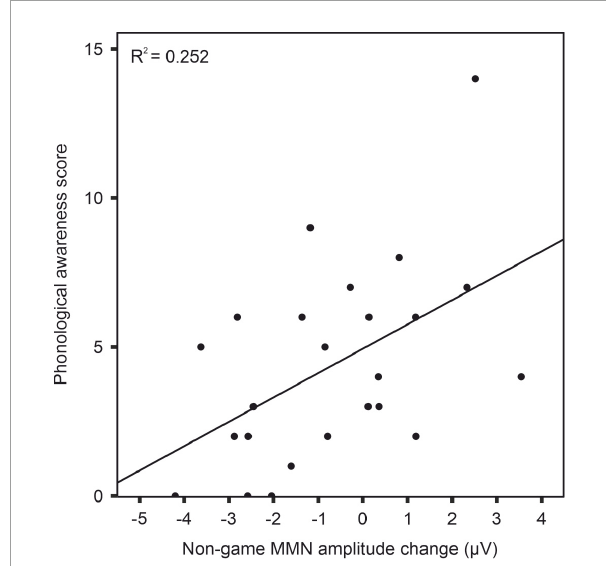
FIGURE7 Correlation between phonological awareness and MMN amplitude change after training with the non-game in dyslexia group. Note that the MMN amplitude change reflects the difference between post-test and